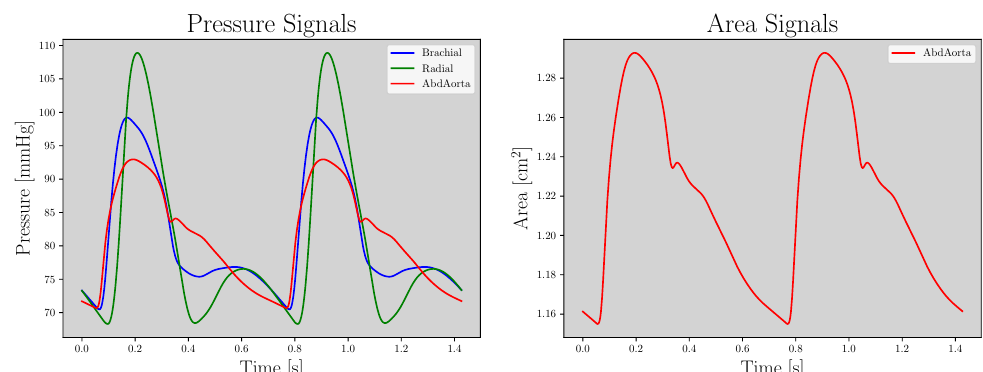
Figure 2. Left : Brachial, radial and abdominal aorta pressure signals (blue, green, and red lines, respectively). Right : Abdominal aorta area